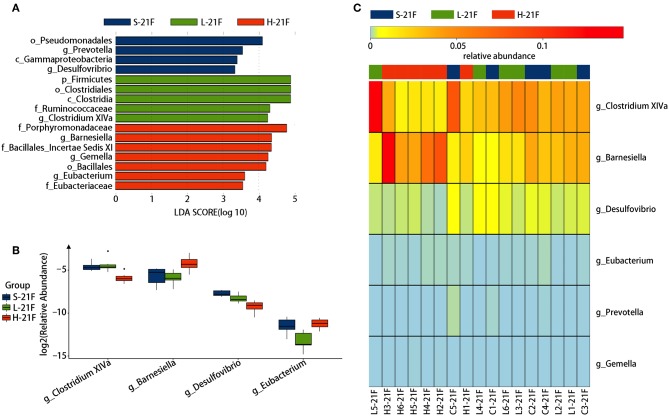
Significant influence of identified fecal microbiota at the genus level on the 21st day post-treatment of spirulina at low and high doses. (A) Histogram of the LDA scores of differential phylotypes abundant among treatment groups according to LEfse analysis; (B) Heatmap and (C) Barplots of the relative abundance of significantly differentiated bacteria among all three treatment groups. S-21F, L-21F, and H-21F represent fecal samples from saline, low, and high dose groups on day 21st, respectively. Differential significant analysis of abundance and composition of gut microbiome was analyzed at the OTUs level by the Kruskal-Wallis test.